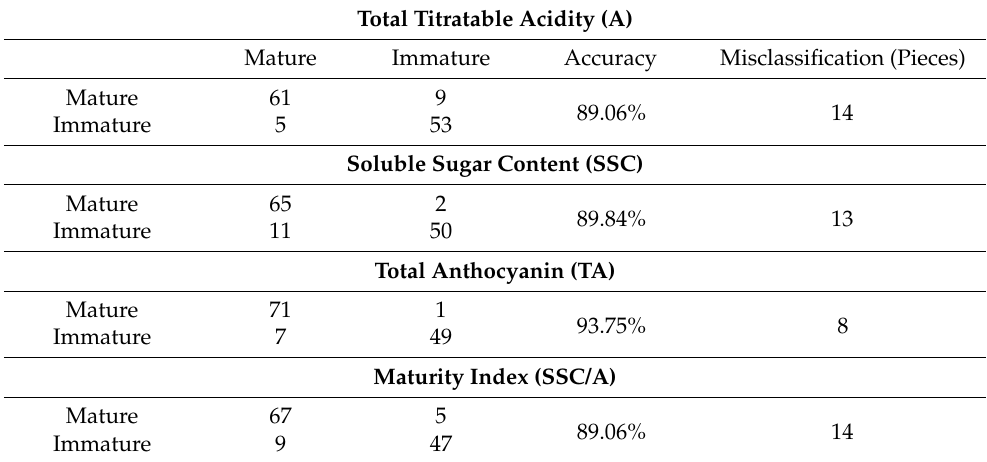
Table 7. Quadratic Discriminant Analysis Classification results-based raw spectra (confusion matrix).